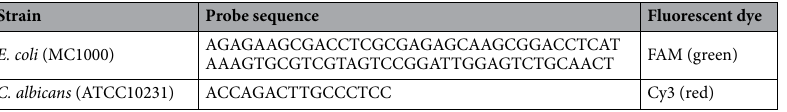
Table 1. Primer probe